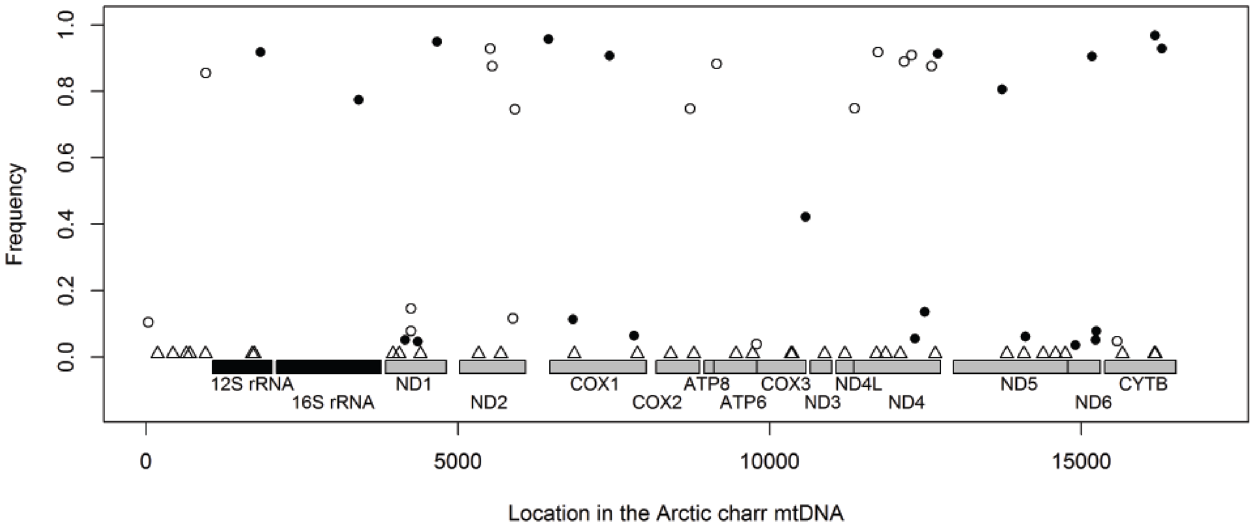
Figure 7. Genetic divergence in the mtDNA between SB- and AC-charr. The frequency differences between morphs of candidate SNPs, estimated from the RNA-sequencing, graphed along the mtDNA chromosome. The SNPs indicate whether the derived allele is of higher frequency in SB (black dots) or AC (open circles). Sites of divergence between the Icelandic stocks and the Canadian reference sequence are indicated by triangles. The two black boxes represent the rRNA genes and gray boxes the 14 coding sequences (abbreviated names underneath each